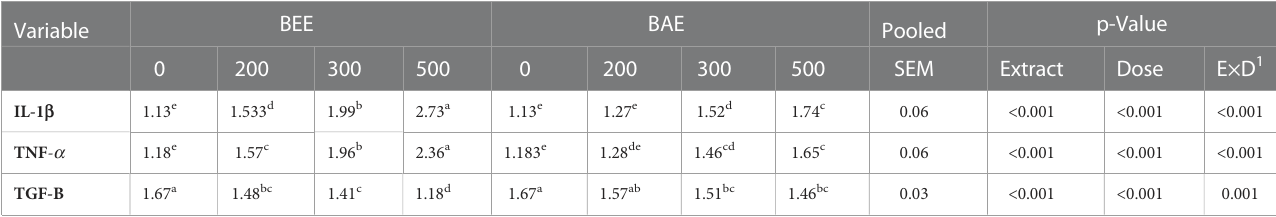
TABLE 7 Effect of dietary supplementation of basil ethanol and aqueous extracts (mg kg -1 of feed) on relative expression of some immune related genes in head kidney of Nile tilapia, O. niloticus . Variable BEE BAE